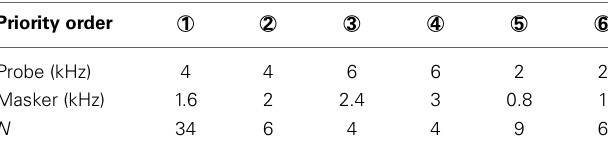
Table 1 | Prioritized linear-reference TMC conditions and number of cases ( N ) where each condition applied (see also red curves in Figure